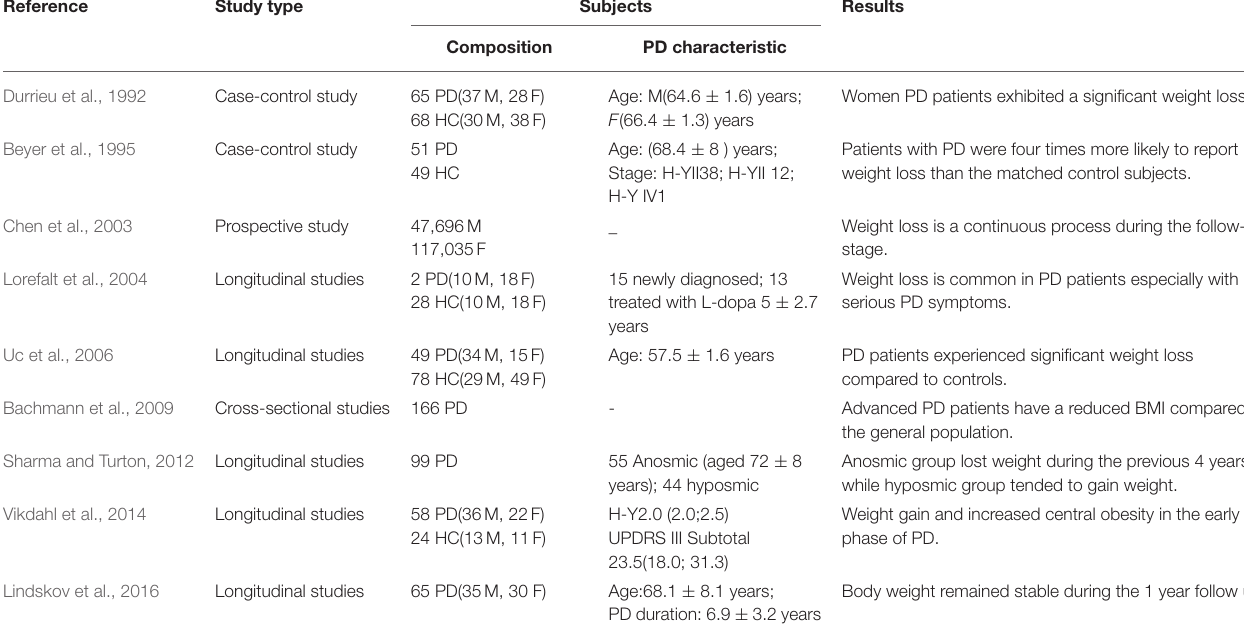
TABLE 1 | Summary of literature on weight change in PD